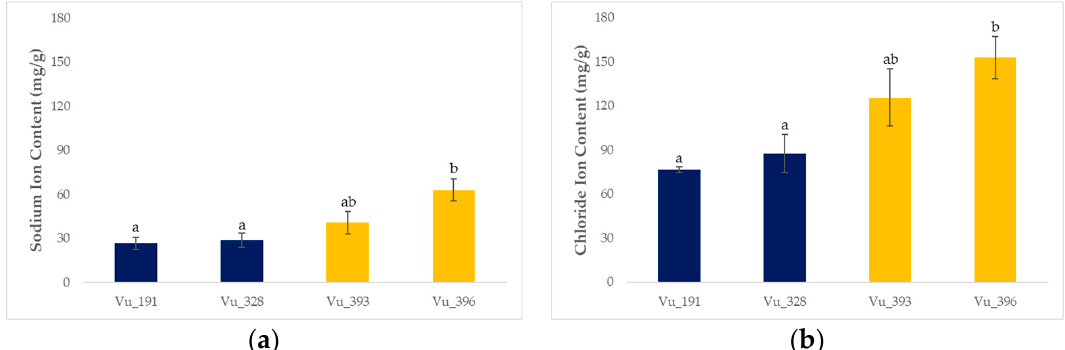
Figure 1. Four cowpea germplasms with different levels of salt tolerance exposed to a 250 mM NaCl solution for three weeks.